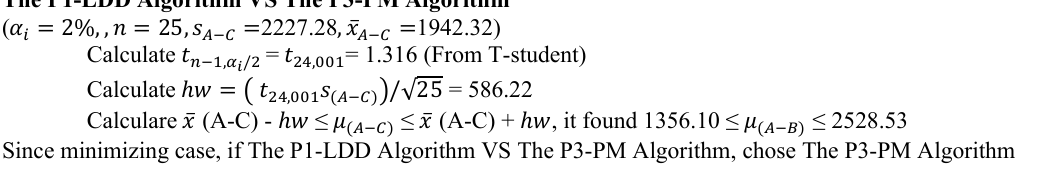
The P1-LDD Algorithm VS The P3-PM Algorithm